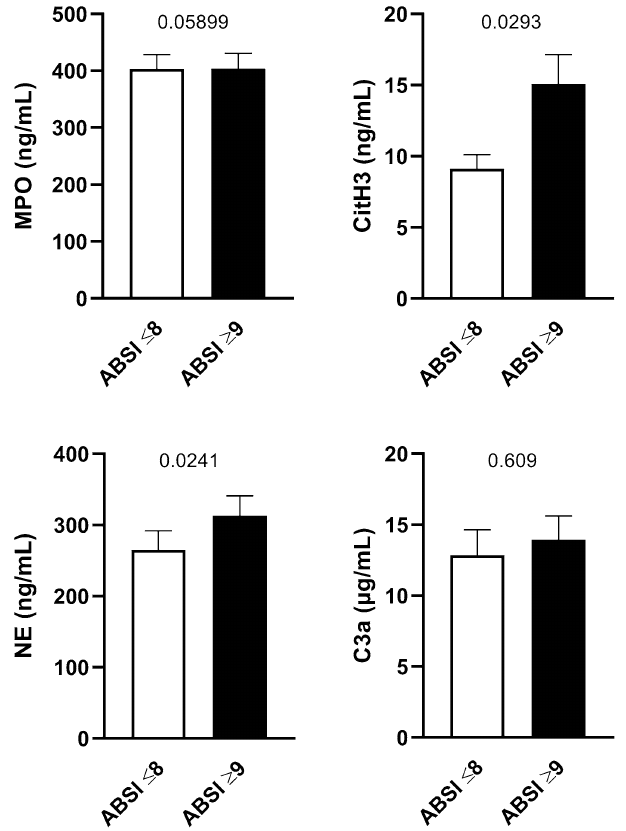
Figure 4. Serum concentrations of neutrophil-derived factors in low and high ABSI scores. ABSI scores were determined on admission day and categorized into low (≤ 8, n = 19) and high (≥ 9, n = 13) values. Serum concentrations of MPO, CitH3, NE, and C3a of the first 7 days post admission were compared. Data were statistically evaluated by Mann–Whitney